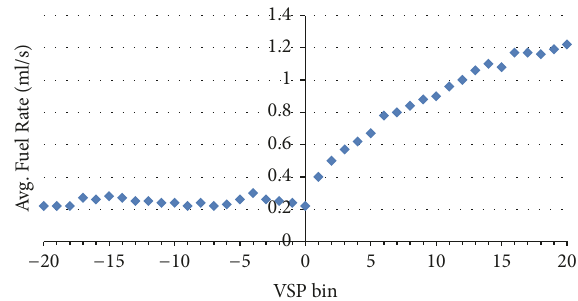
Figure3:Averagefuelrates(mL/s)ineachVSPbinfora2007model